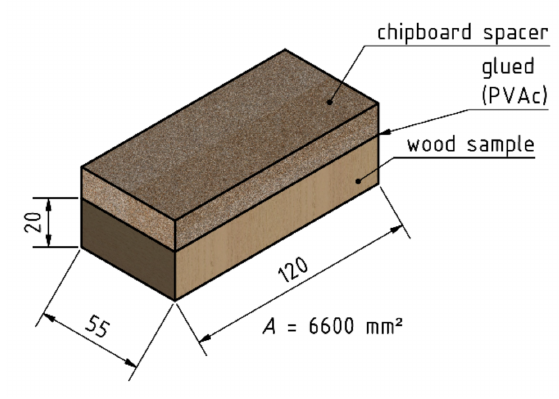
Figure 1. Form of research samples.